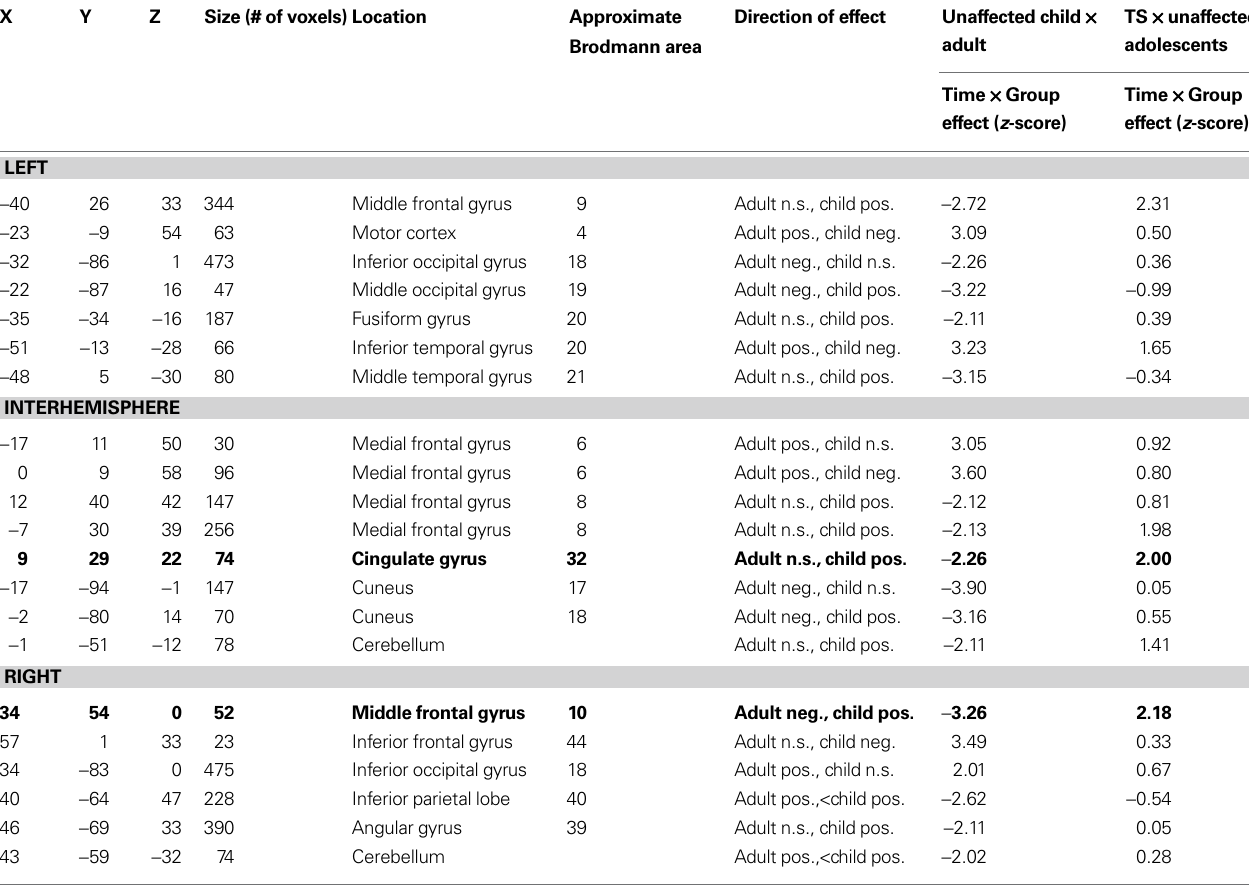
Table 6 | SUSTAINED: Twenty-one brain regions showing a signifi cant sustained group effect between typical children and adults for the picture living/non-living task (sphericity-corrected p -values <